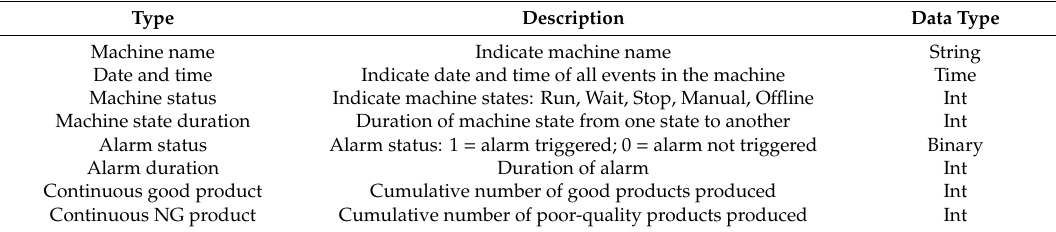
Table 1. Detailed information of raw data gathered from PLC.